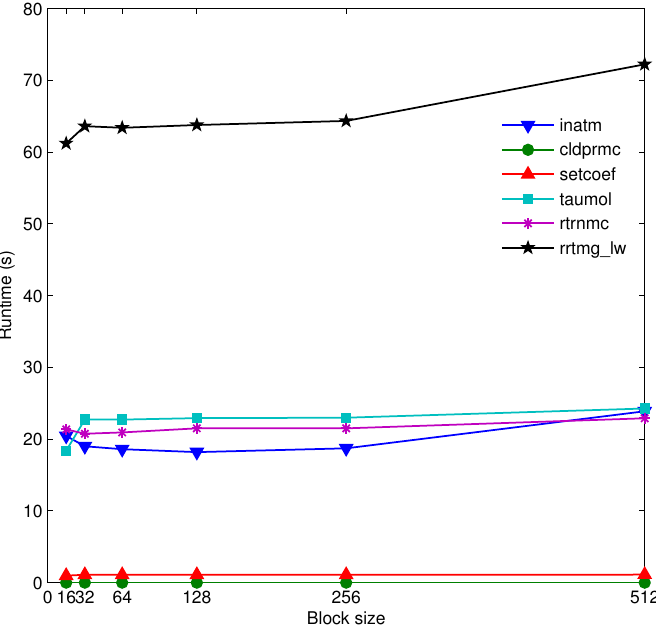
Figure 5. Run-time of the 1-D G-RRTMG_LW on one K20